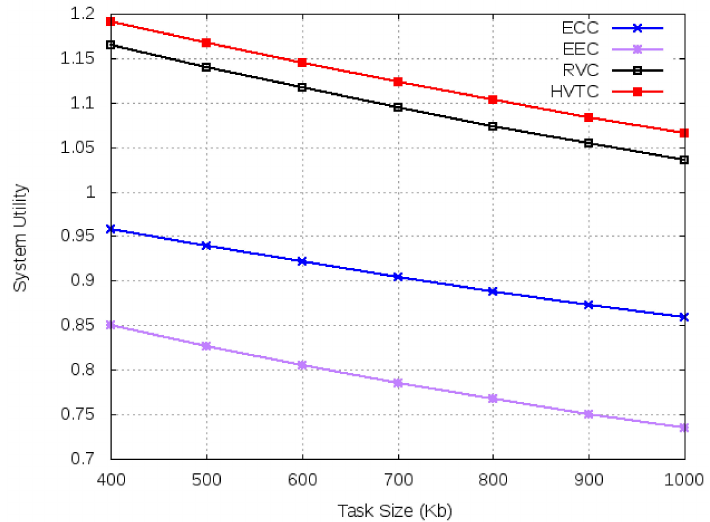
Figure 11. System utility for varied task size.